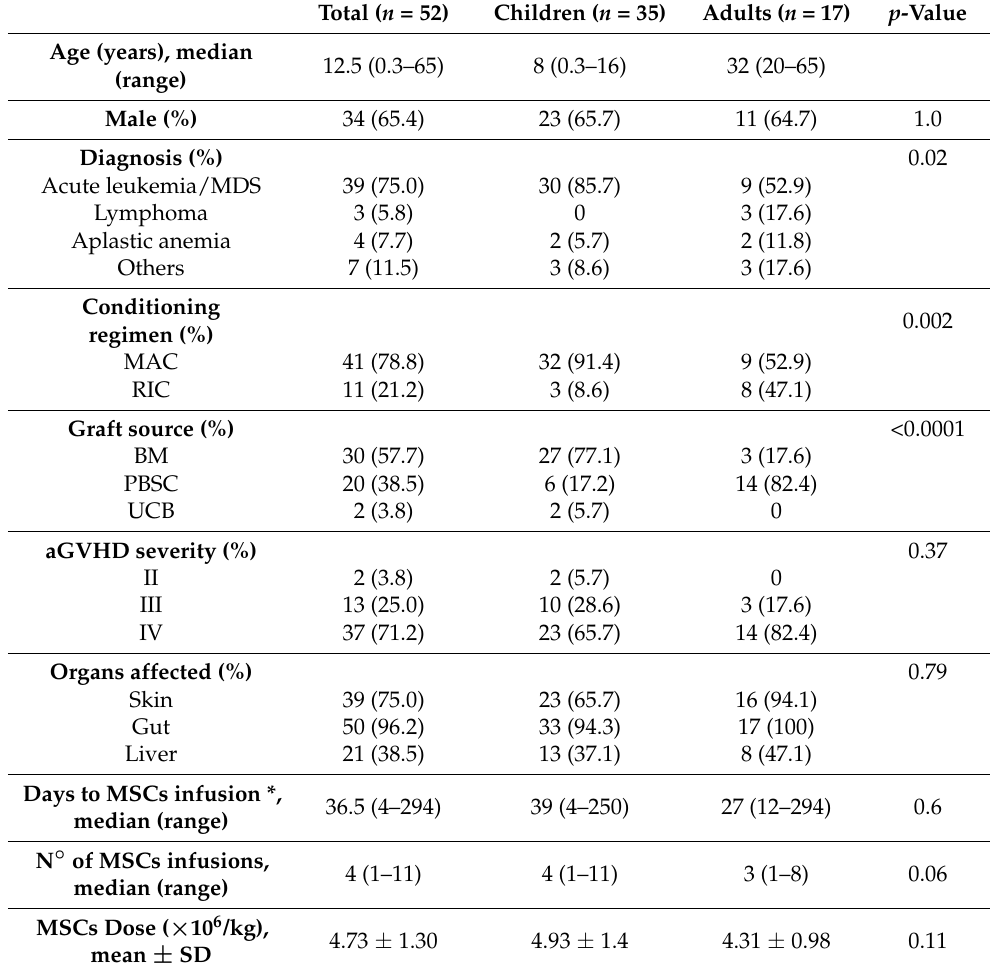
Table 1. Clinical characteristics of patients with steroid-refractory acute graft-versus-host